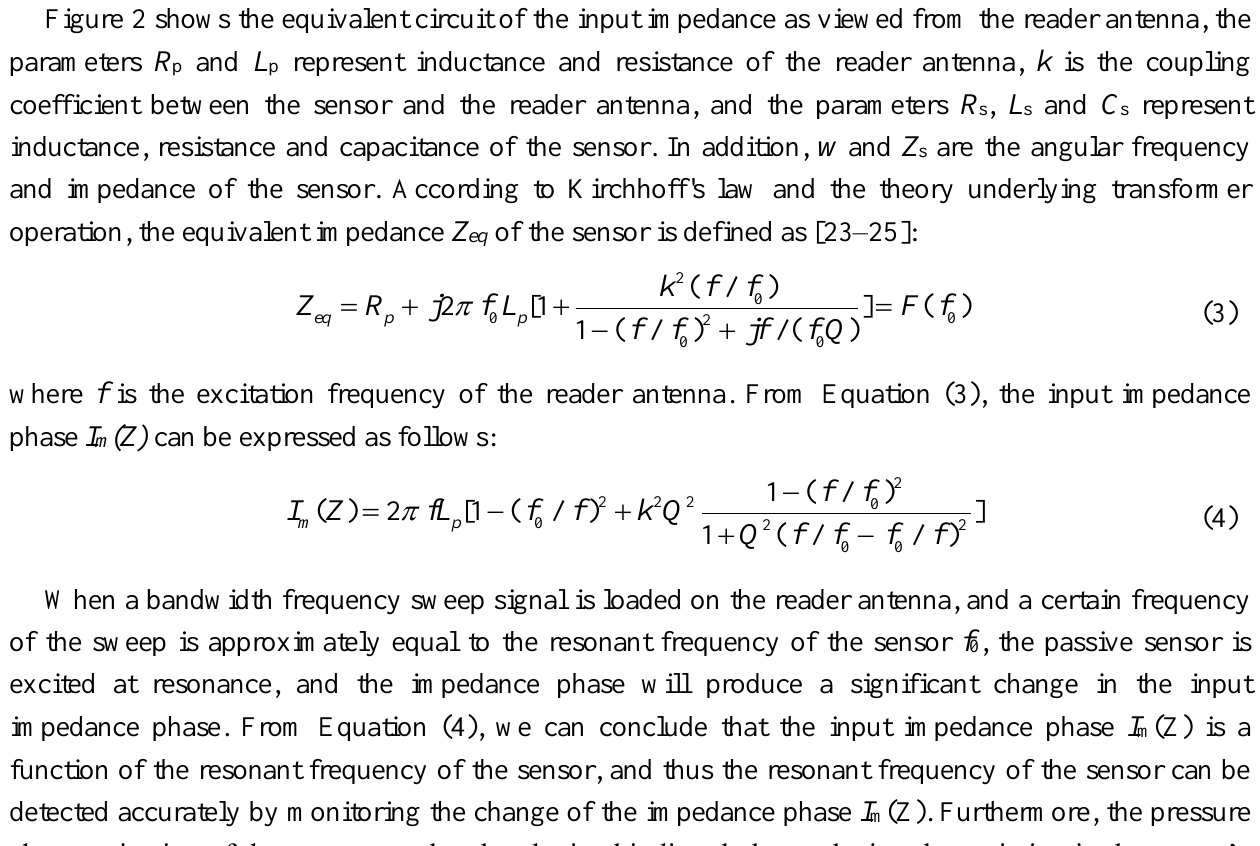
Figure 2. ( a ) Wireless measurement principle; ( b ) Equivalent electric